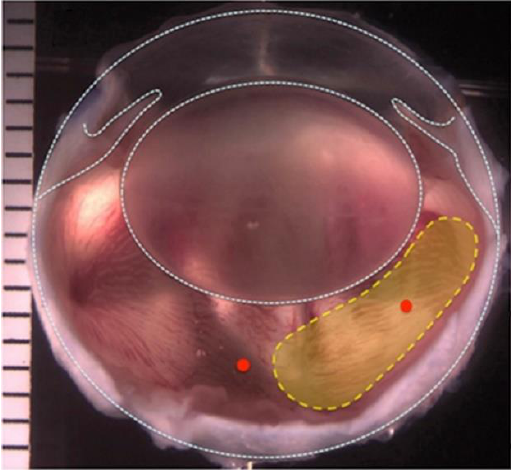
Figure 1. Image of a rabbit’s eye. Yellow region indicates the area where the natural vitreous was removed during the two-port partial pars plana